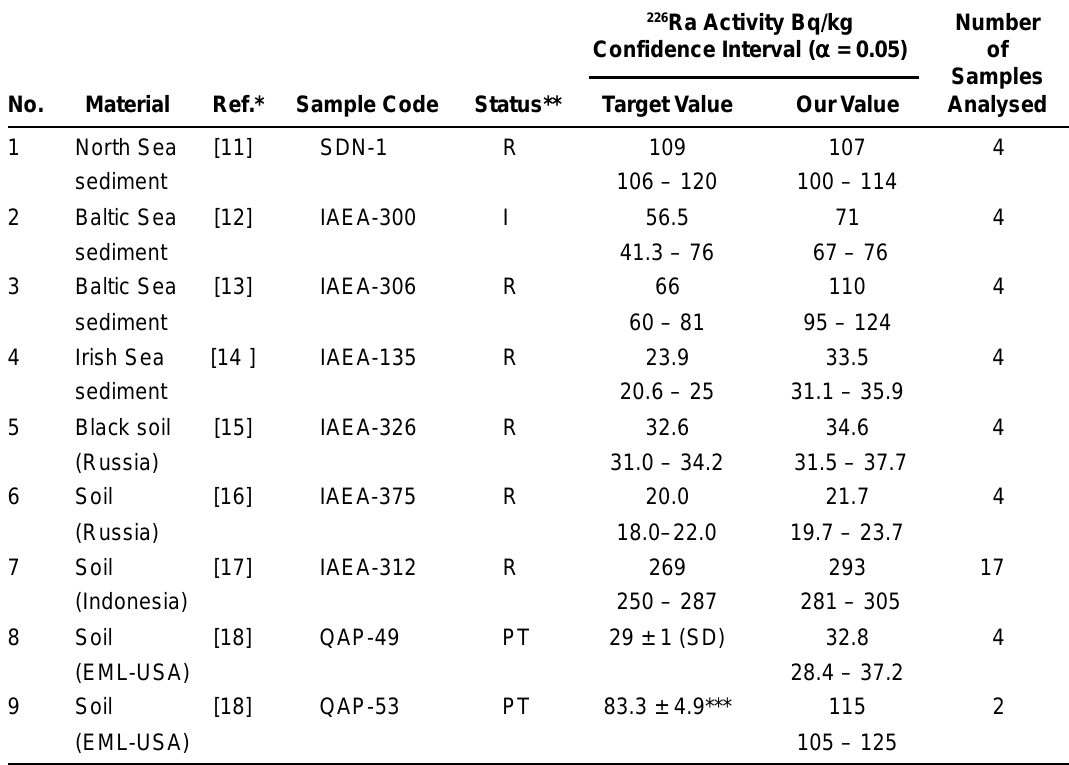
Results of 226 Ra Measurements in Selected Reference